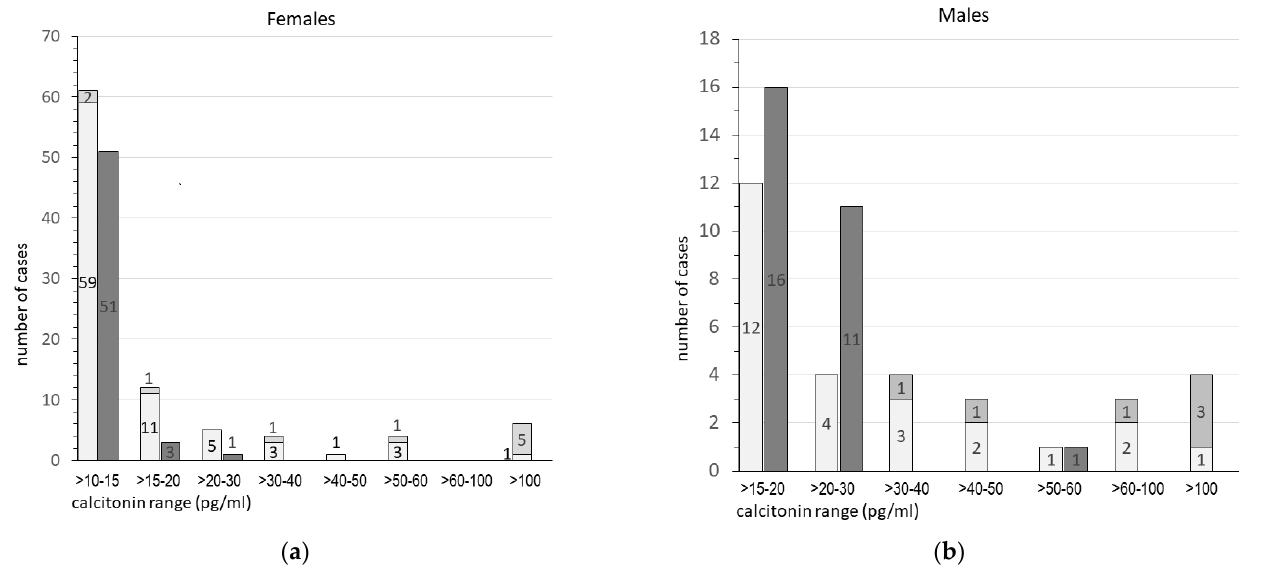
Figure 2. ( a , b ). Histograms of the distribution of the Ctn values above the sex-specific reference ranges (female patients = left side; male patients = right side). White columns: patients in whom MTC could be excluded; light gray columns: patients with confirmed MTC; dark gray columns: patients in whom no further clarification of the Ctn elevation was possible. Considering the distribution of the Ctn values, the statistical extrapolation showed that in 2 additional female patients of the 83 patients with increased Ctn values for whom no further clarification was possible (dark gray columns), MTC could be expected.